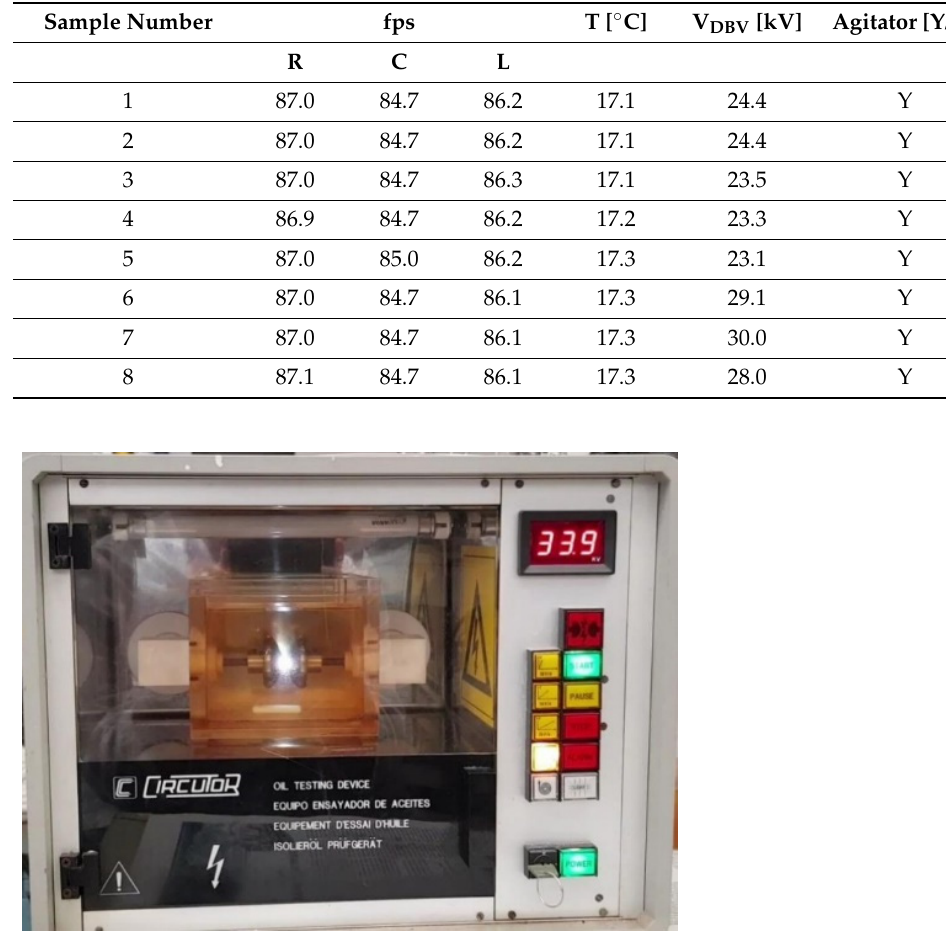
Table 7. Breakdown voltage. Ramp of 0.5 kV/s.